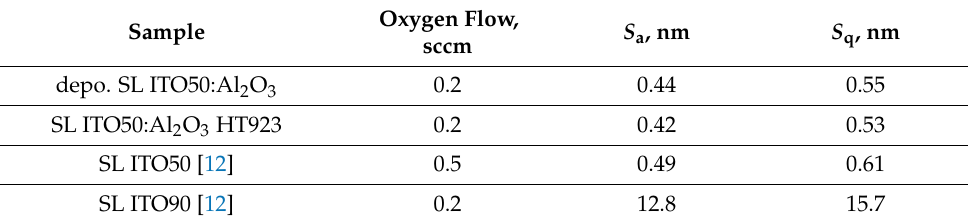
Table 2. Arithmetical mean height ( S a ) and root mean square height ( S q ) of depo. and HT923 ITO50:Al2O3 (PHS) thin films in comparison with as-deposited ITO50 (PHS) and ITO90 (PHS).